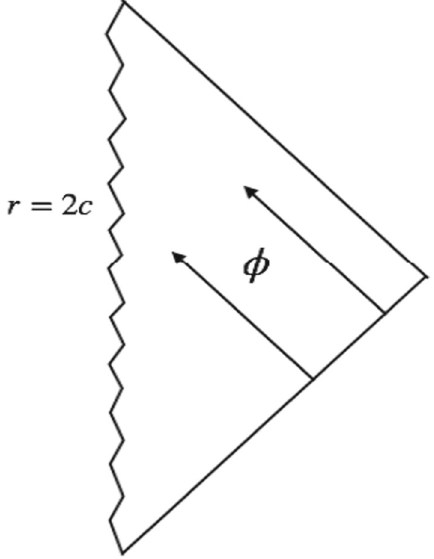
Fig. 5 Penrose diagram for the HMN spacetime( a = 0 , c (cid:4)= 0). There is a naked singularity at r = 2 c